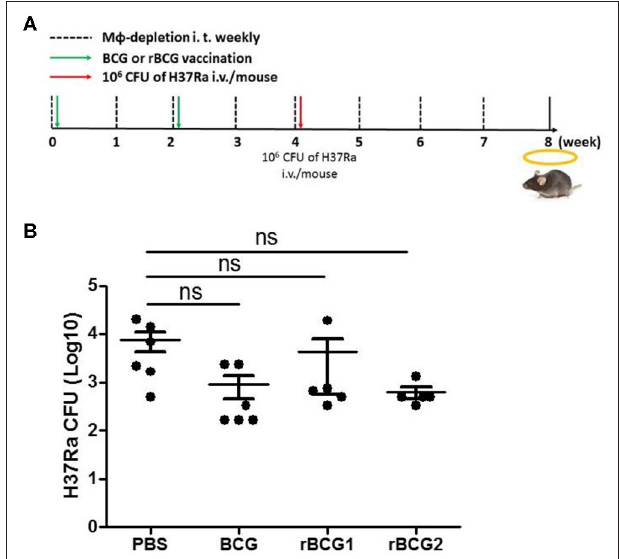
FIGURE 6 | Macrophages are significant for protection against Mycobacterium infection. C57BL/6 mice were given a two-dose vaccination of parental BCG, rBCG1, and rBCG2 (5 × 10 5 CFU per mouse) subcutaneously at weeks 0 and 2 ( n = 6), and a challenge of H37Ra at week 4; they also received 50 µ l of encapsome ® (control) or clodrosome ® intratracheally weekly for 8 weeks to deplete macrophages. Mice were sacrificed at week 8. (A) Timeline for vaccination, challenge, and intratracheal inoculation in mice. (B) CFU of bacterial growth in murine lung at week 8. Each plate contained 100 µ l of tissue homogenate, and each sample was titrated for two dilutions (5 × and 50 × ) and repeated in triplicate. Differences among groups were determined using one-way ANOVA with a Tukey post hoc test ( P > 0.05, ns,